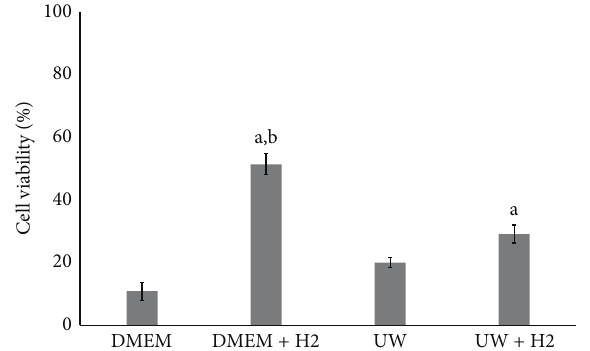
Figure 3: Effect of hydrogen on cell viability of OCT after cold preservation for 3 weeks in DMEM and UW solution. Data are presented as the mean ± SE ( 𝑛 = 10 ). a Significant difference between the H2-treated and H2 nontreated groups ( 𝑃 < 0.05 ). b Significantly different between the UW with H2 and DMEM H2 groups ( 𝑃 < 0.05 ).